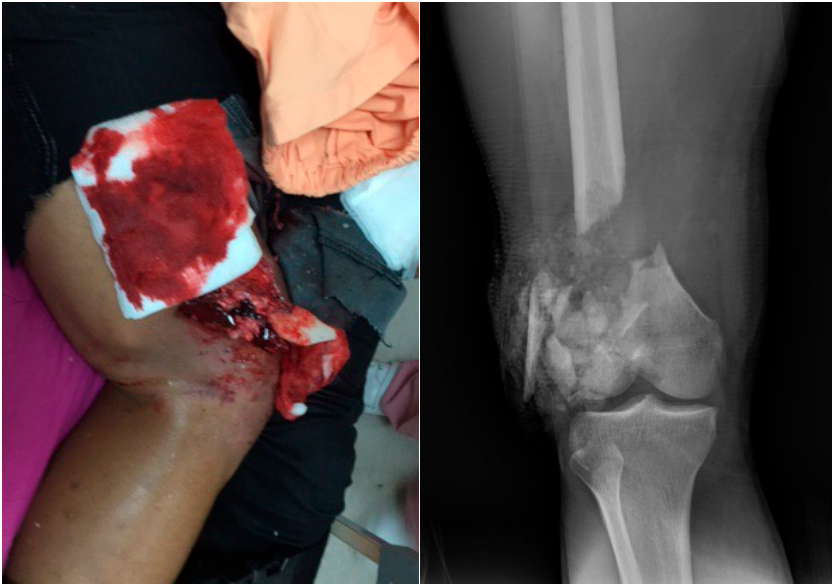
Figure 1. A 17 y/o patient with right distal femur fracture with >15 cm open wound. The X-ray showed Figure 1. A 17 y / o patient with right distal femur fracture with > 15 cm open wound. The X-ray showed severe comminution of the fracture with large segmental bone defect. severe comminution of the fracture with large segmental bone